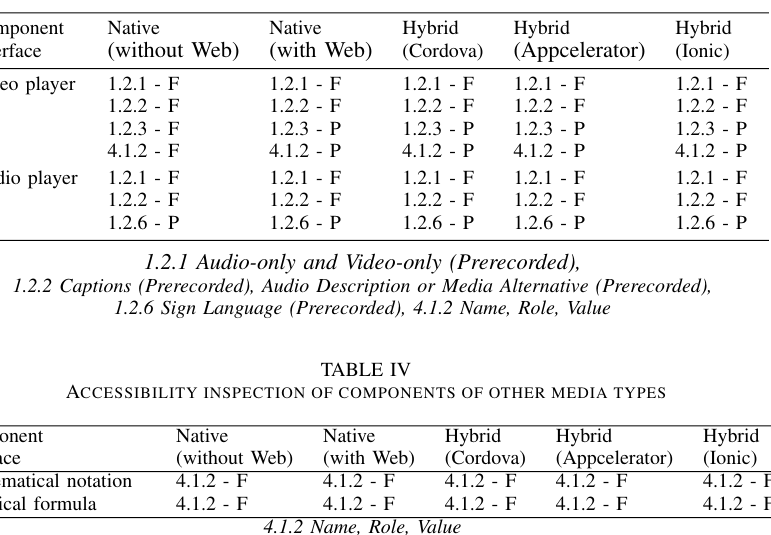
TABLE III A CCESSIBILITY INSPECTION OF AUDIO , VIDEO AND MULTIMEDIA COMPONENTS